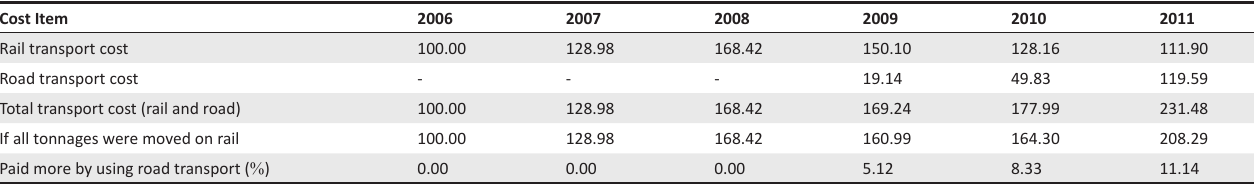
TABLE 3: Difference in transport costs (indexed